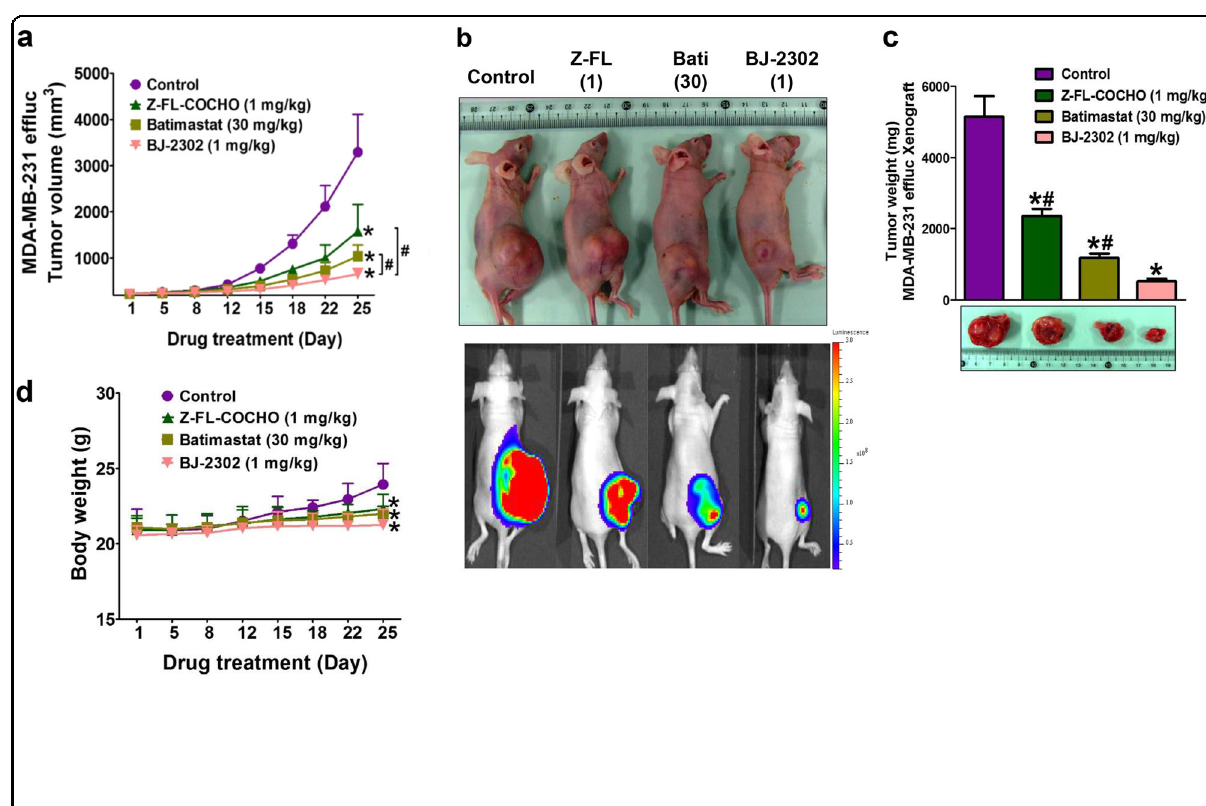
Fig. 7 BJ-2302 inhibited tumor growth in MDA-MB-231 tumor xenografted models. Z-FL-COCHO (1 mg/kg), batimastat (30 mg/kg), or BJ-2302 (1 mg/kg) was administered intraperitoneally to mice xenografted with MDA-MB-231-effLuc cells. a , d The mean tumor volume ( a ) and mouse body weight ( d ) were measured during the drug treatment period. b , c On the 25th day of drug treatment, BLI was performed ( b ), and excised tumor weights were measured ( c ). Each group contained six mice. The bar-diagram represents quantitative data. * P < 0.05 compared to vehicle-treated mice. # P < 0.05 compared to BJ-2302-treated